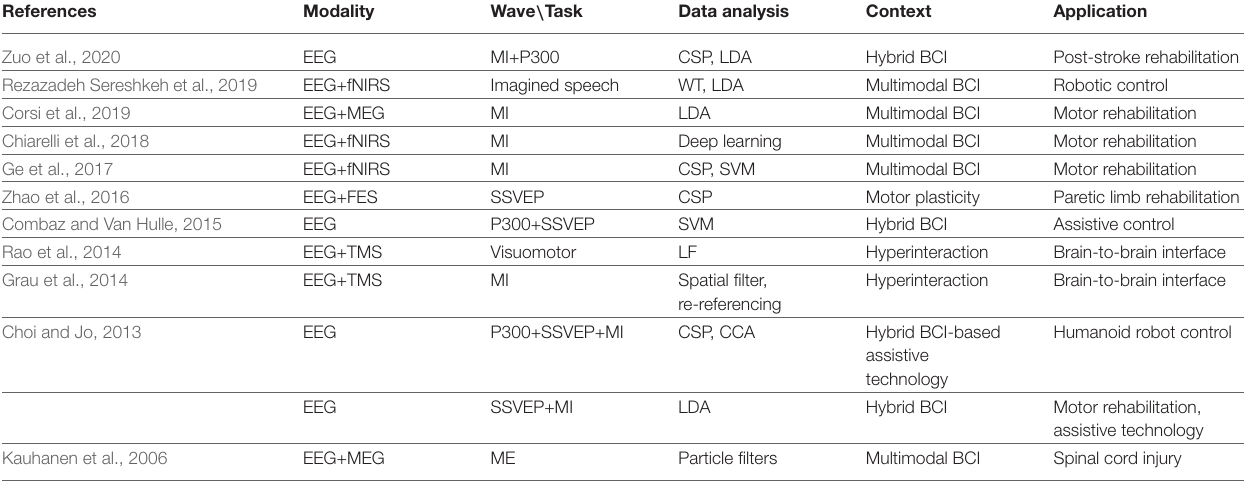
TABLE 4 | A summary of multimodal and hybrid brain computer interface (BCI) studies.